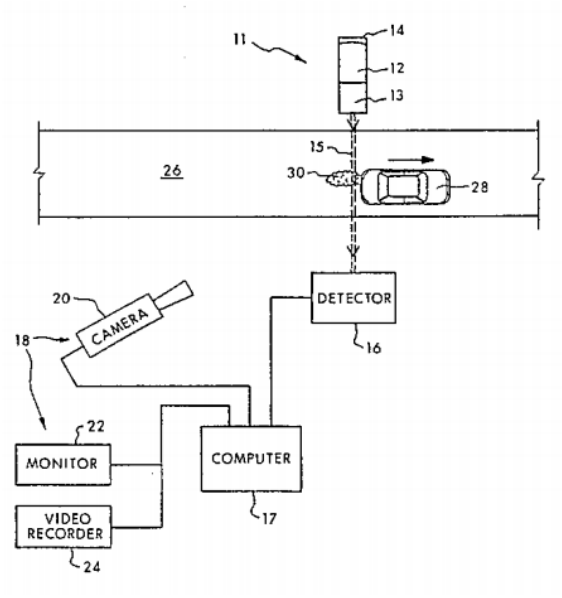
Fig. 1. Operating principle of the device described in Patent US5498872(A) titled „Apparatus for remote analysis of vehicle emissions” [9]  Patent designated DE4235235(A1) titled “Continuous